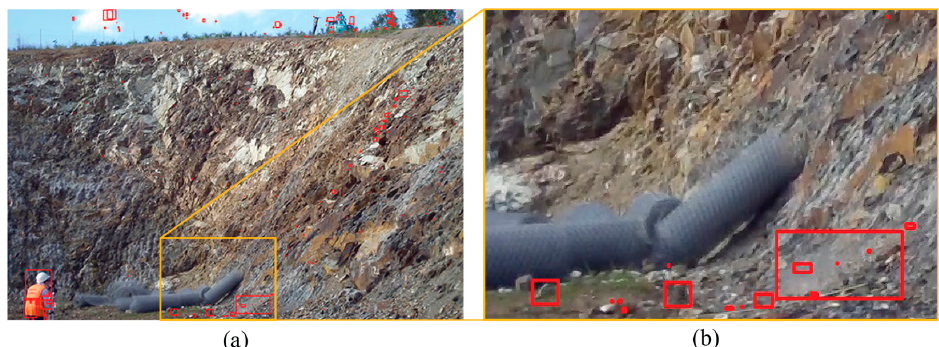
Figure 8. Contextual images—examples of detection results from the SSIM algorithm: ( a ) detected rock fragments inside red boxes along the rockfall path; ( b ) zoomed regions.